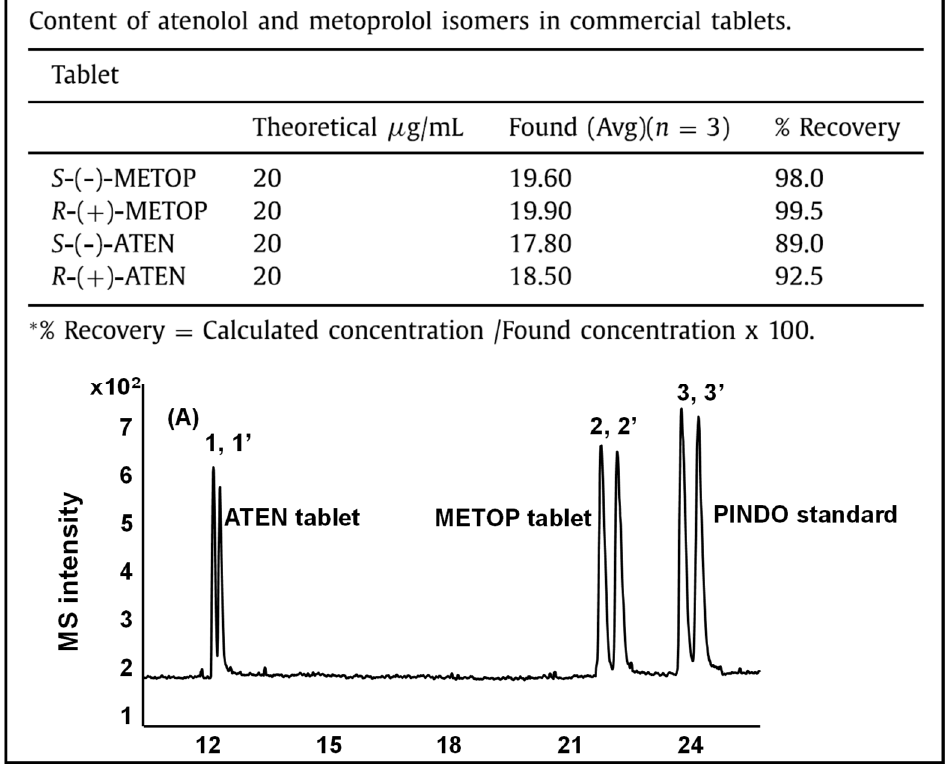
Figure 9. A typical chromatogram for the analysis of a mixture prepared by using: (A) R.S -ATEN, and R,S -METOP tablets. Peak identification: 1 = S -( − )-ATEN, 1’ = R -(+)-ATEN, 2 = S -( − )-METOP, 2’ = R -(+)-METOP, 3 = S -( − )-PINDO, 3’ = R -(+)-PINDO. All other MEKC-MS conditions are the same as indicated in Table 2 (row 1) except using 5 mbar for 50 s at +30 kV. The inset table shows content of atenolol and metoprolol enantiomers measured in commercial prescription tablets. Adapted from Akter et al. [56], with permission from Elsevier.